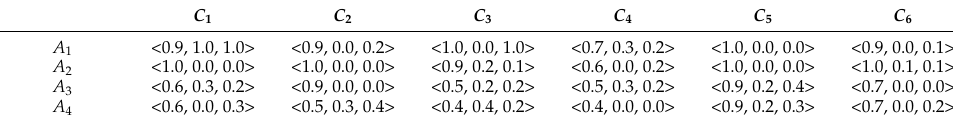
Table 3. The ratings of three tablets obtained from the third of three IT specialist.